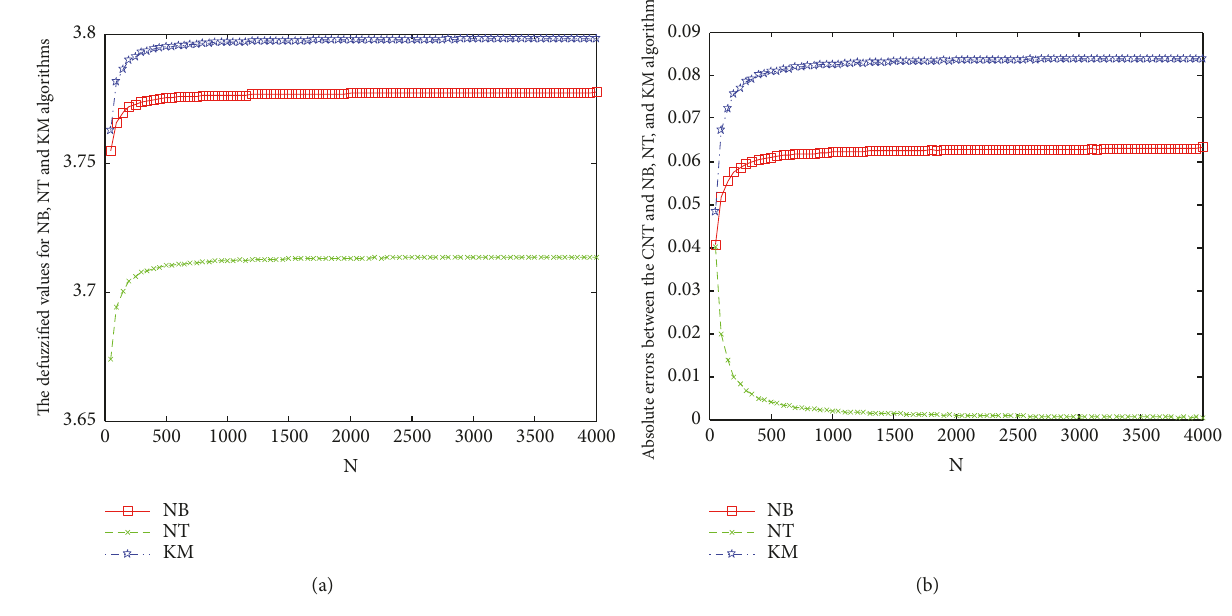
Figure 4: Calculation results of example